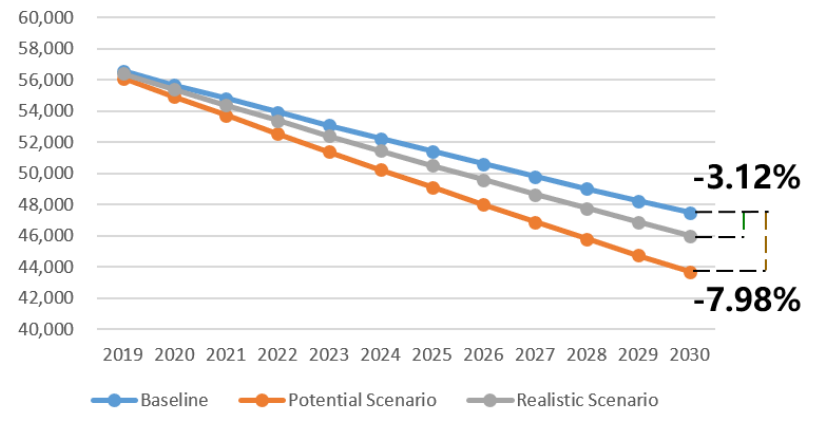
Figure 3. Road tra ffi c fatalities for three scenarios through Figure 3. Road traffic fatalities for three scenarios through 2030.